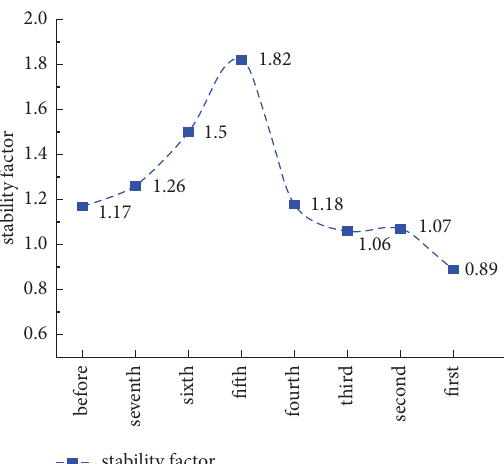
Figure 16: Stability coefcient curve obtained by numerical simulation.